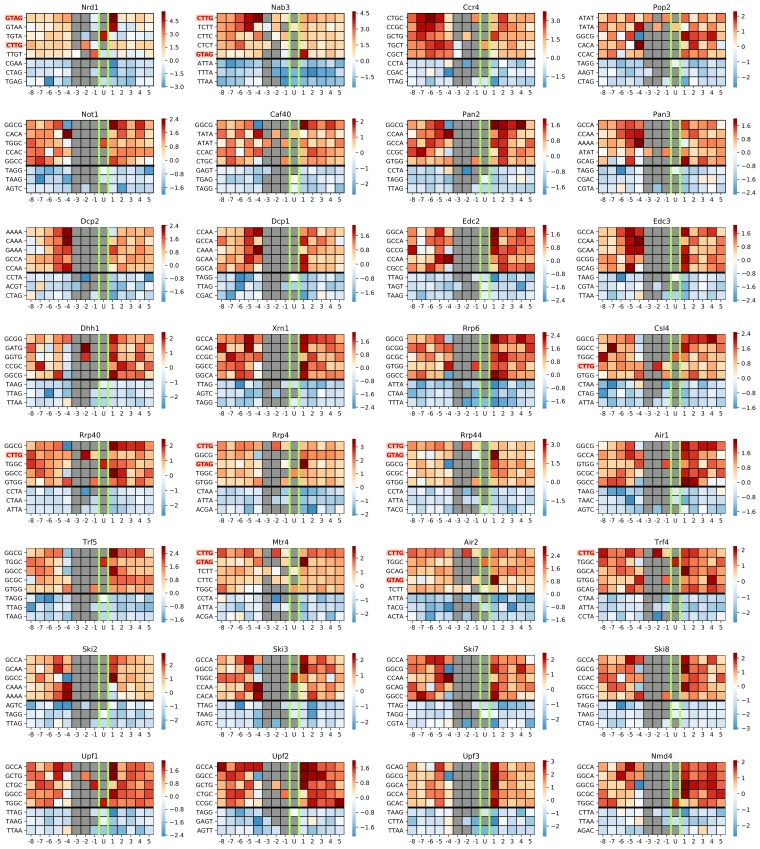
Motif enrichment analysis shows enrichment of Nrd1/Nab3 motifs for the TRAMP4 and the exosome complex.Motif analysis was performed for all degradation factors in this study. Nrd1 and Nab3 are included for comparison (Schulz et al., 2013). Occurrences of Nrd1 motif (GTAG) and Nab3 motif (CTTG) are highlighted with red. The color code shows the log2 enrichment factor of top five enriched and top 3 depleted 4-mers around PAR-CLIP cross-link sites [±8 nt]. Dark red represents strong enrichment and dark blue shows strong depletion of a 4-mer. Infeasible combinations are shown with gray.